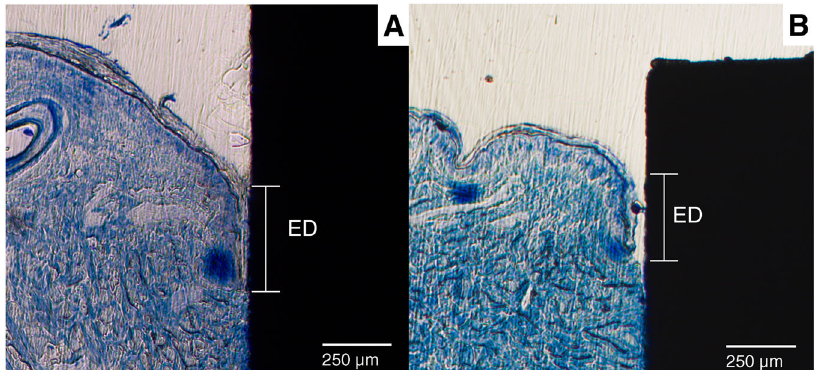
Fig. 6 Histology slide, stained with toluidine blue, of an implant and surrounding skin. ED Epidermal downgrowth, TC Tissue contact length, TH Tissue height. TIC was calculated as TC/TH